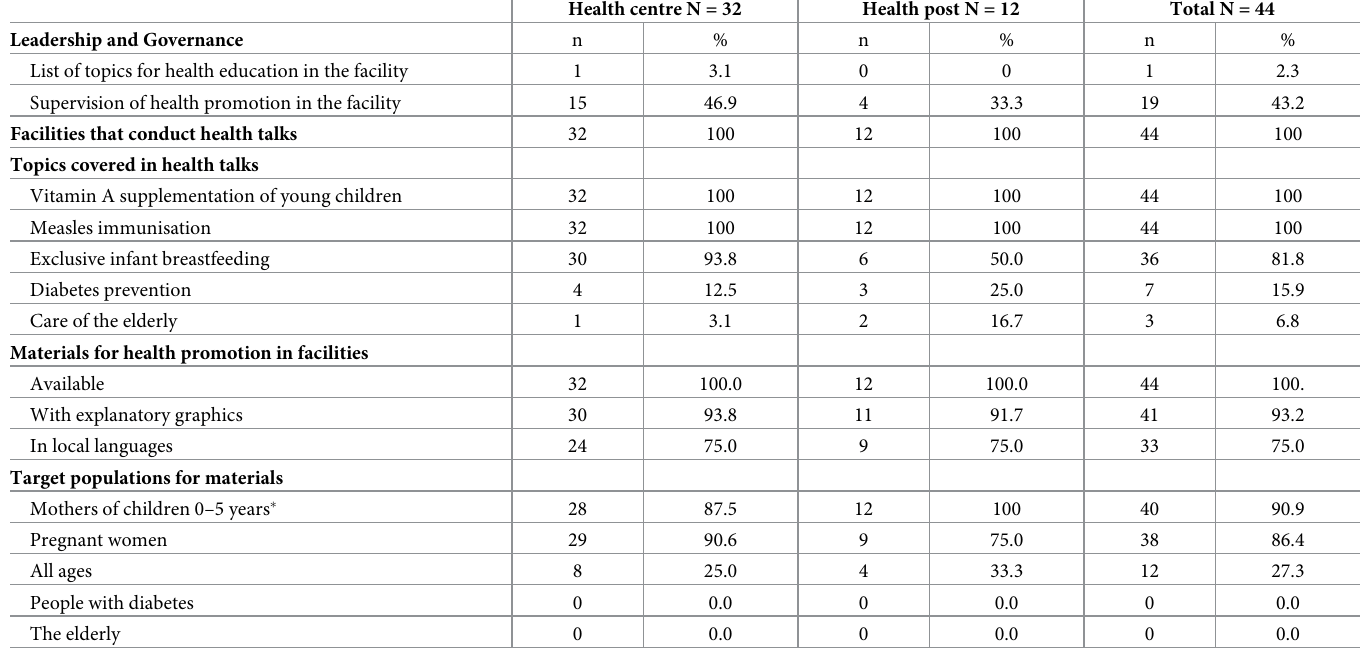
Table 5. Materials to support health promotion in primary health care